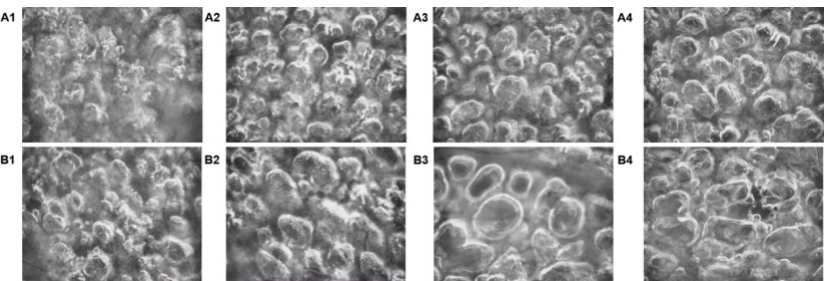
Figure 4. SDF images under high and low cardiac output and different PEEPs. At high cardiac output (Panel ( A )), the microcirculation gradually improved with increasing PEEP. However, at low cardiac output (Panel ( B )), with the increase in PEEP, the SDF showed more obvious vascular collapse and interruption of blood flow, which suggested local microcirculation occlusion. The video can be found in the Supplemental Video S2.